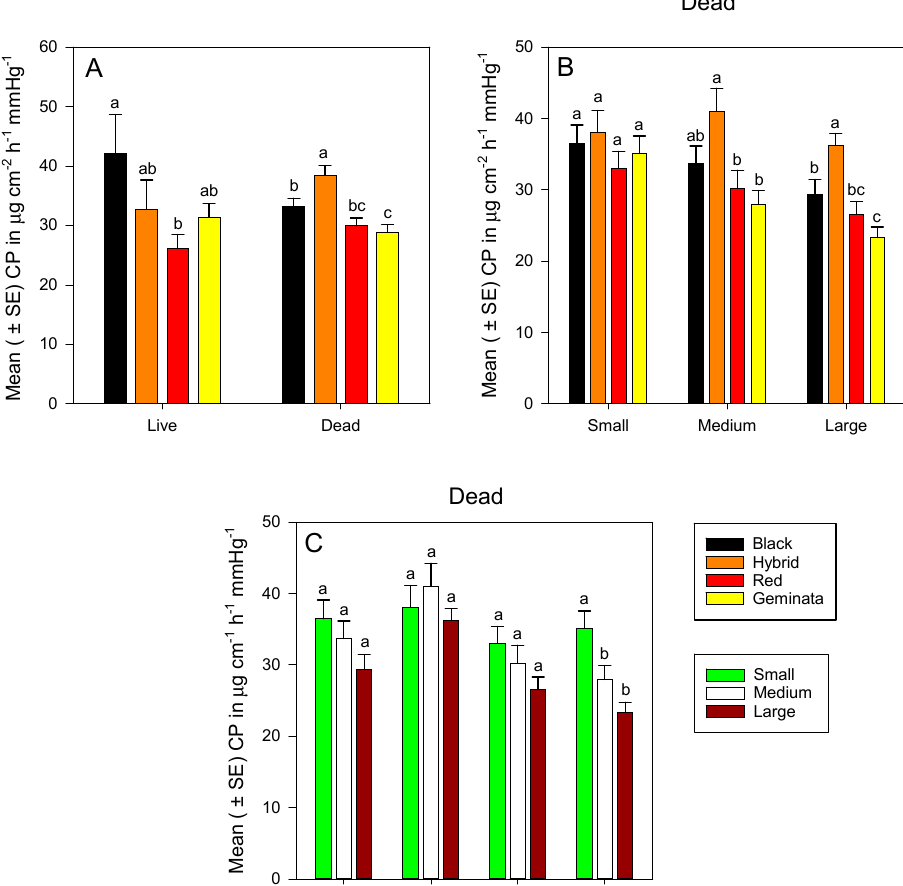
Figure 3. Mean ( ± SE) calculated cuticular permeability (CP) for: ( A ) Combined worker size classes of S . richteri (Black), S . invicta × S . richteri (Hybrid), S . invicta (Red), and S . geminata (Geminata) fire ants compared within each live / dead status; ( B ) Dead S . richteri , S . invicta × S . richteri , S . invicta , and S . geminata fire ants compared within each worker size class; and ( C ) Dead small, medium, and large ant worker size classes compared within each Solenopsis species. Table 3. LT 50 values (h) for live small, medium, and large workers of S . richteri , S . invicta × S . richteri , S . invicta , and S . geminata ants.